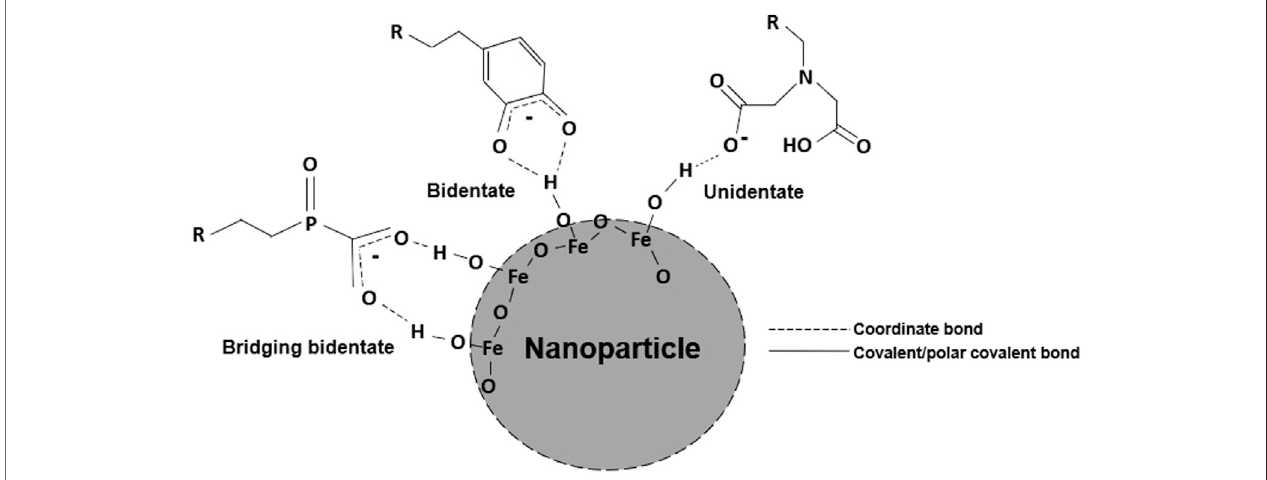
FIGURE 1 | Schematic illustrating coordination bonding between chelating agents of various dents and the hydrogens of the surface − OH (hydroxyl) groups of a metal oxide nanoparticle.